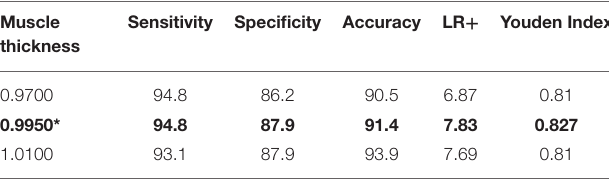
TABLE 3 | Diagnostic value of various cut-off point of muscle thickness in determining PS. Muscle